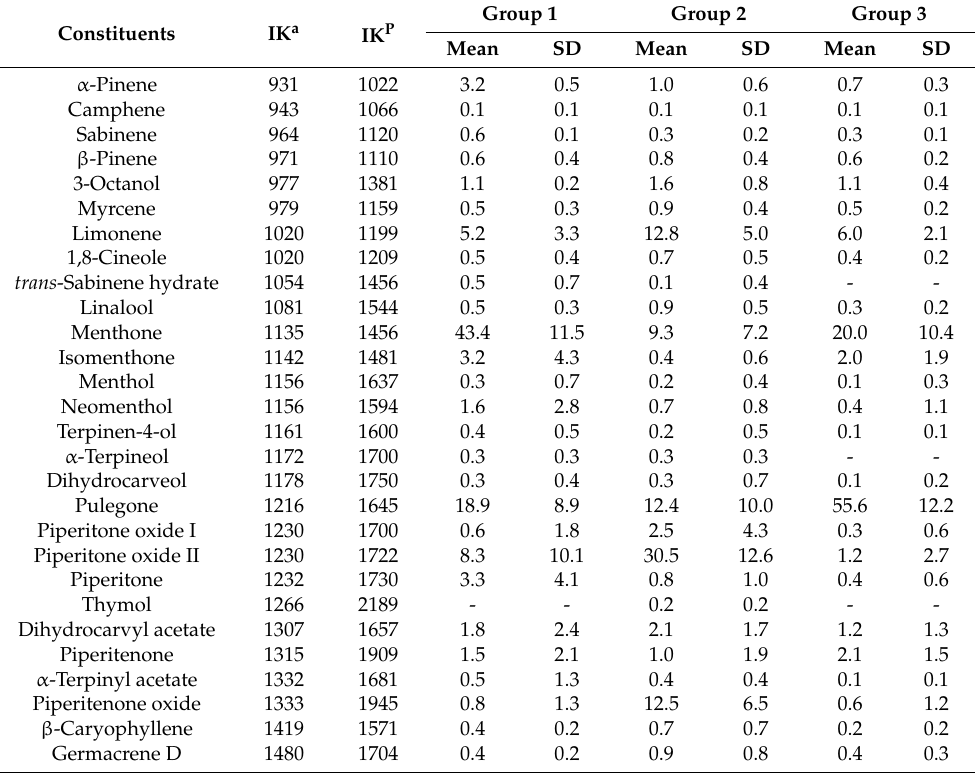
Table 3. Chemical composition of groups 1–3 of the EOCN from Corsica expressed as relative percentage [34].